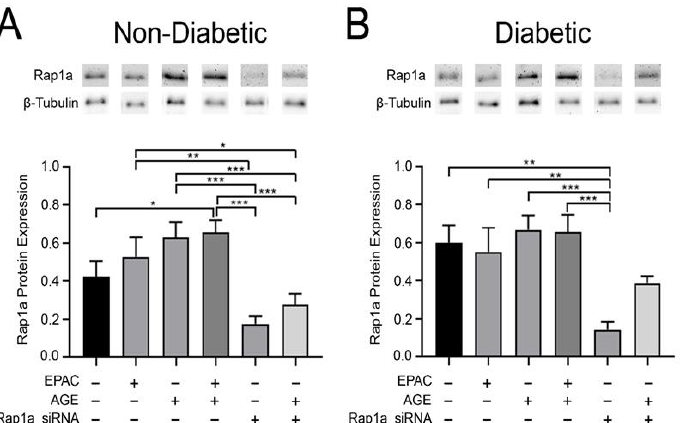
Figure 2. Treatment with exogenous AGEs and EPAC induced an increase in Rap1a protein expres- sion. Cardiac fibroblasts were isolated from non-diabetic and diabetic mice hearts. Fibroblasts were either untreated, treated with a single pharmacological modifier, or treated in combination with EPAC (100 µM), EPAC+AGE (100 µM and 0.5 mg/mL, respectively), Rap1a siRNA (100 nM), or Rap1a siRNA + AGE (100 nM and 0.5 mg/mL, respectively). Rap1a (21 kDa) protein expression was assessed in ( A ) non-diabetic and ( B ) diabetic fibroblasts. Expression of Rap1a was normalized to β -tubulin (55 kDa) and mean ± SEM are depicted (n = 5–11). Representative western blot images are shown above graphs but are not displayed as a continuous blot due to running order on the blot not aligning with graphical order of samples. However, original western blot images are available at DOI:10.6084/m9.figshare.12625409. Statistical analysis consisted of one-way ANOVA followed by a Fisher’s protected least significant difference post hoc (* p < 0.5, ** p < 0.01, *** p <